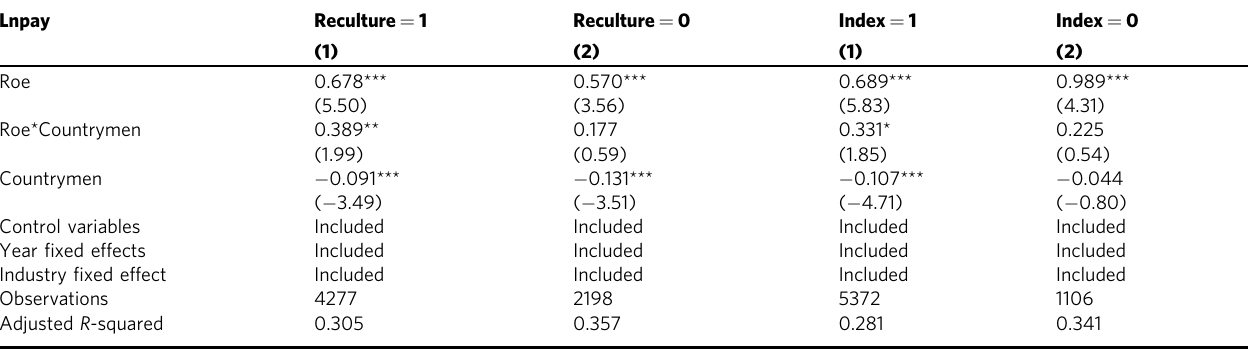
Table 7 The in fl uence of hometown culture and marketization degree.